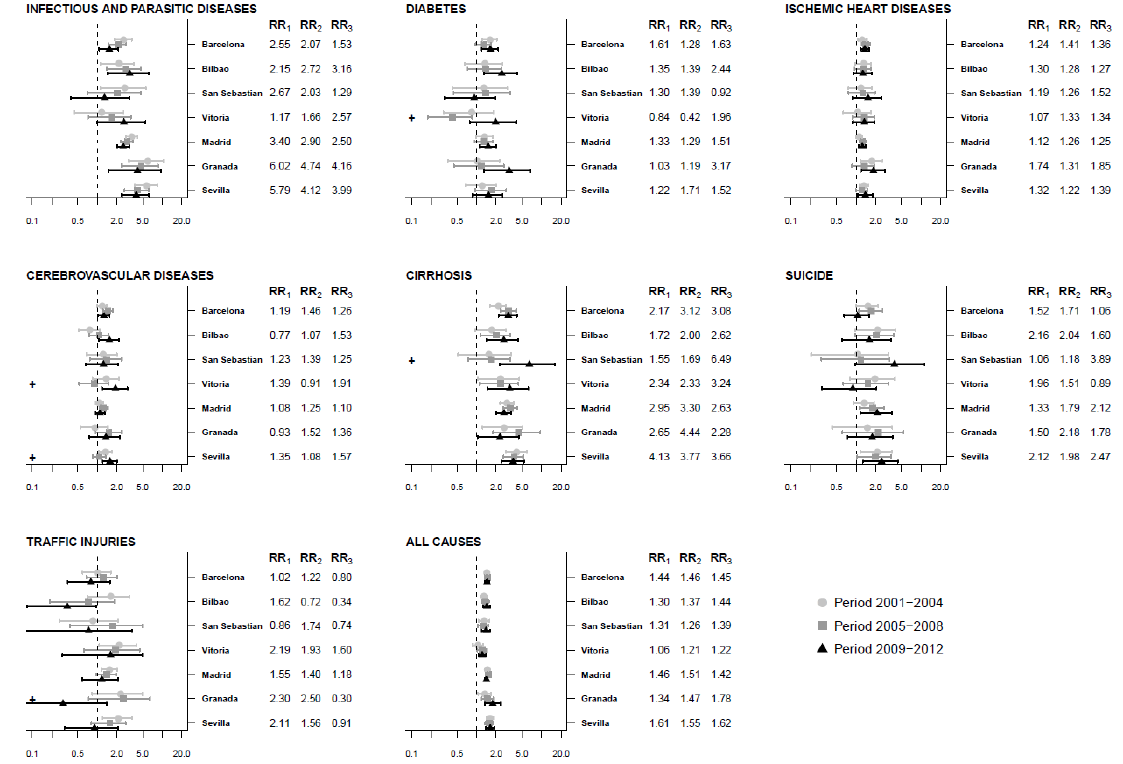
Figure 2. Association between the deprivation index and mortality. Relative risk comparing the 95th to 5th percentiles of the deprivation index by period and cause of death in seven Spanish cities for men, 2001–2012. Note: + indicates that RR 3 is statistically significantly different than RR 2. RR1: RR 2001–2004 period, RR2: RR 2005–2008 period, RR3: RR 2009–2012 period.